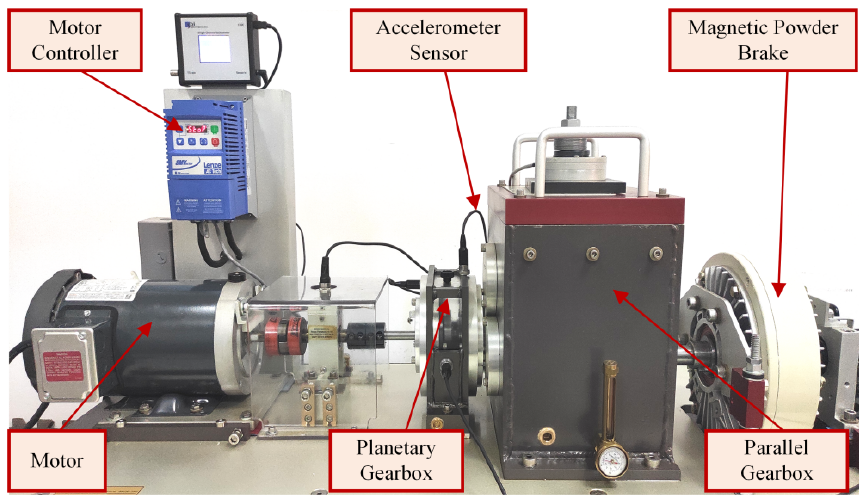
Figure 9. Experiment platform. Table 2. The number of gear teeth in the planetary gearbox. Component